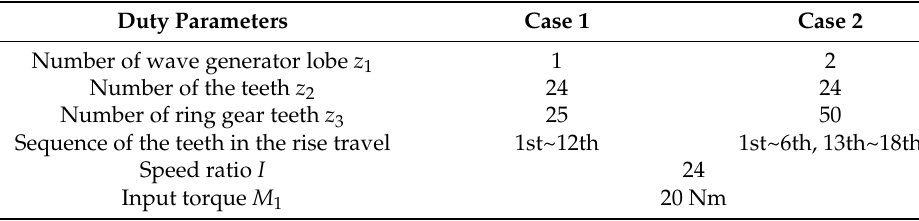
Table 2. Duty parameters of the